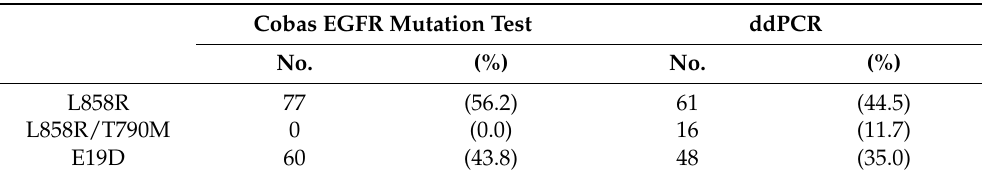
Table 1. Comparison of EGFR mutation status determined from baseline tumor tissues using the cobas EGFR Mutation Test and the ddPCR platform (N =